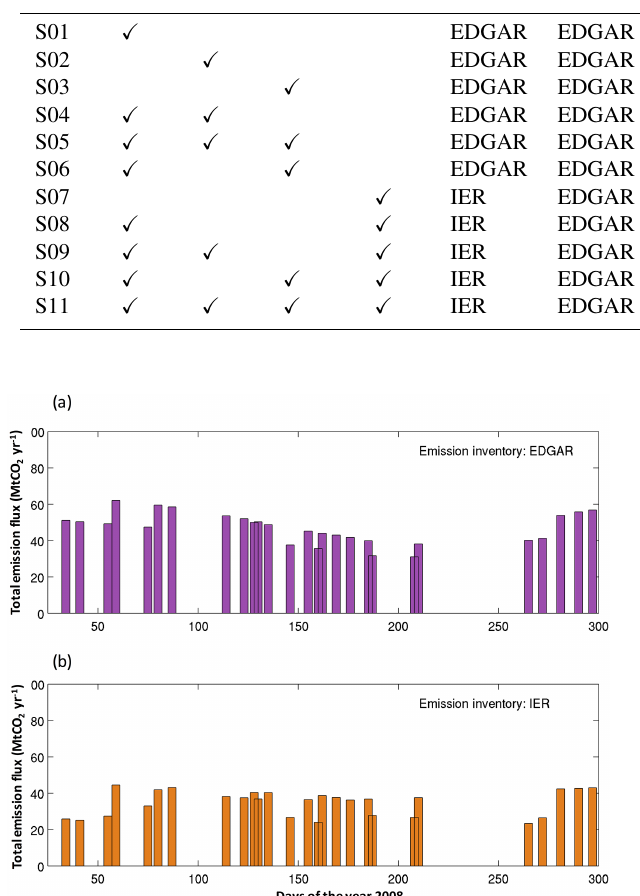
Figure 5. Anthropogenic flux over the target region based on (a) EDGAR inventory, and (b) IER inventory for all of CarbonSat’s useful overpasses corresponding to 500km swath width for the year